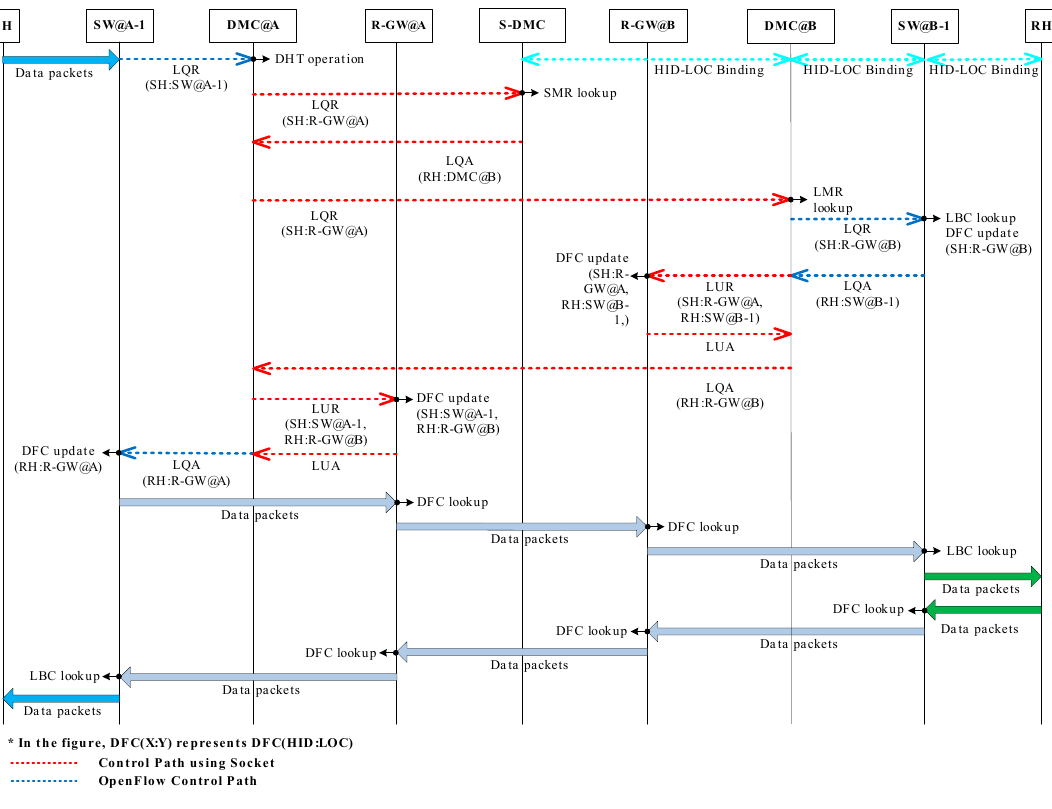
Figure 7. Inter ‐ domain LOC query operations for data delivery (case 2). Figure 7. Inter-domain LOC query operations for data delivery (case 2).